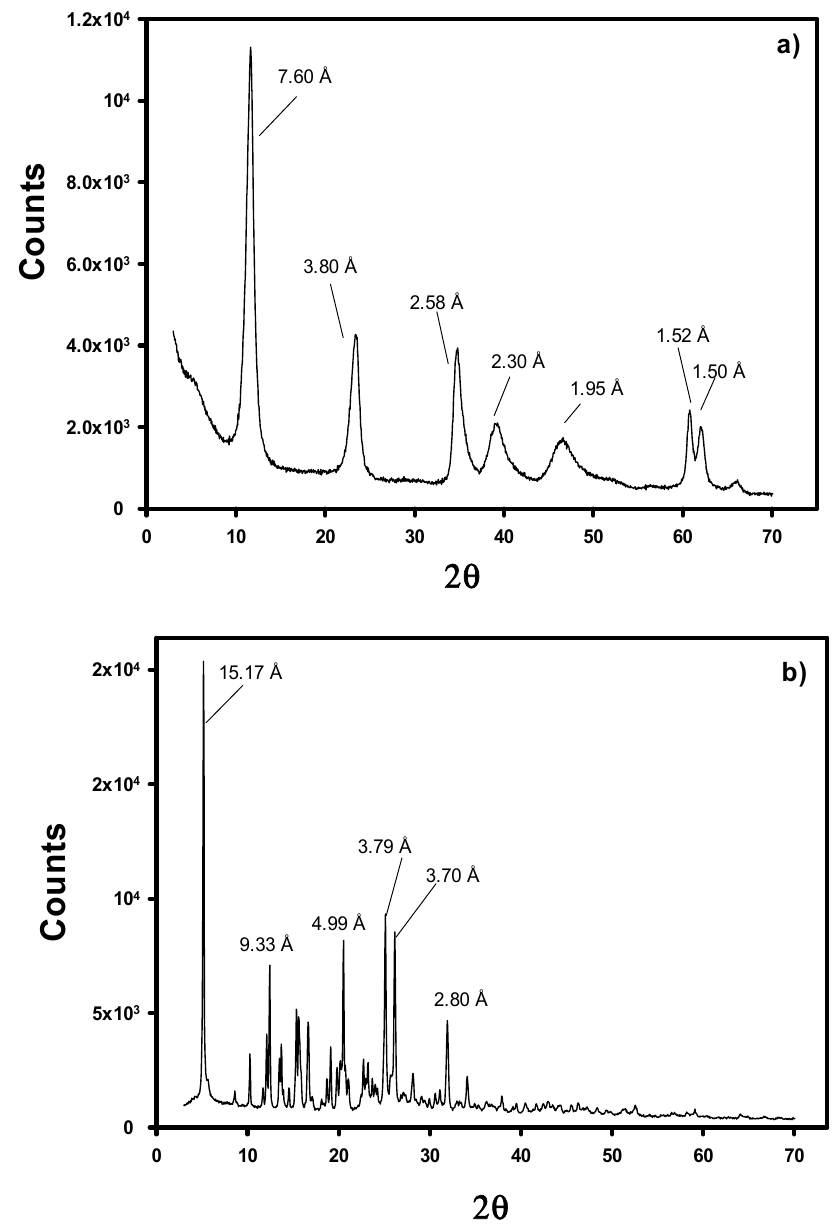
Figure A1. X-Ray di ff raction pattern of original LDH ( a ), and pristine whitening agent ( b Figure A. X-Ray diffraction pattern of original LDH ( a ), and pristine whitening agent ( b ). Appendix B.